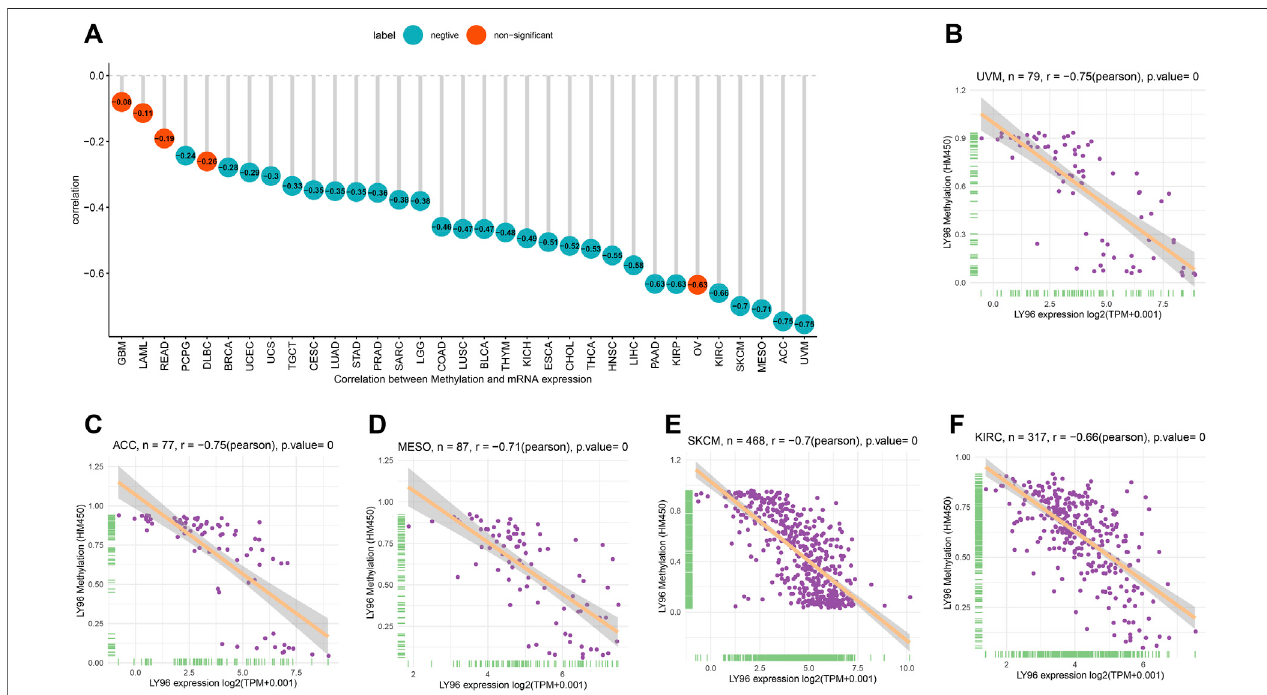
FIGURE 6 | Correlation between LY96 expression and DNA methylation. (A) Correlation between LY96 expression and DNA methylation across cancers. (B – F) Correlation between LY96 expression and DNA methylation in (B) uveal melanoma (UVM), (C) adrenocortical carcinoma (ACC), (D) mesothelioma (MESO), (E) skin cutaneous melanoma (SKCM), and (F) kidney renal clear cell carcinoma